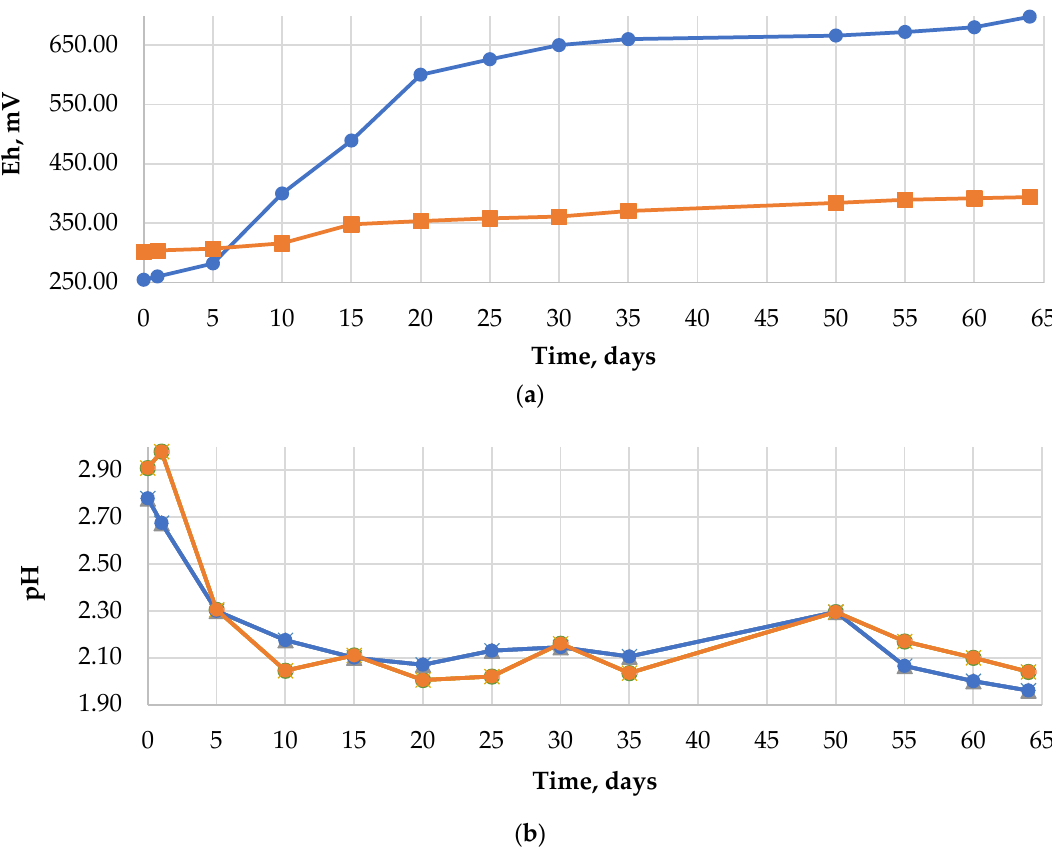
Figure 1. Graphs showing changes in: ( a ) redox potential (Eh), ( b ) pH, during bacterial (blue line) and chemical (orange line) leaching.